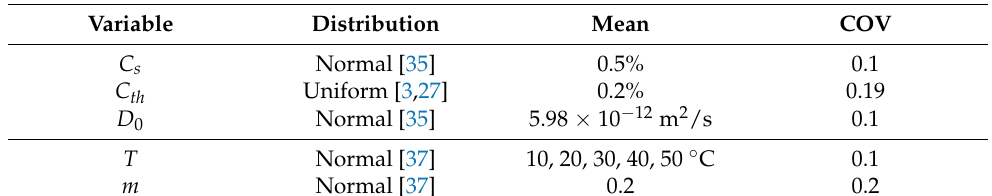
Figure 4. Chloride content distribution in concrete for an exposure time of 60 years. Table 2. Probabilistic models of main random variables.